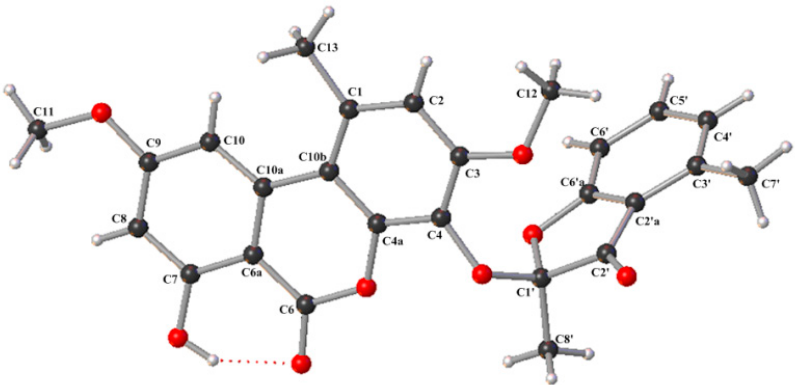
Figure 2. Thermal ellipsoid representation of 1. (Note: A different numbering system is used for the structural data deposited with the CCDC.).